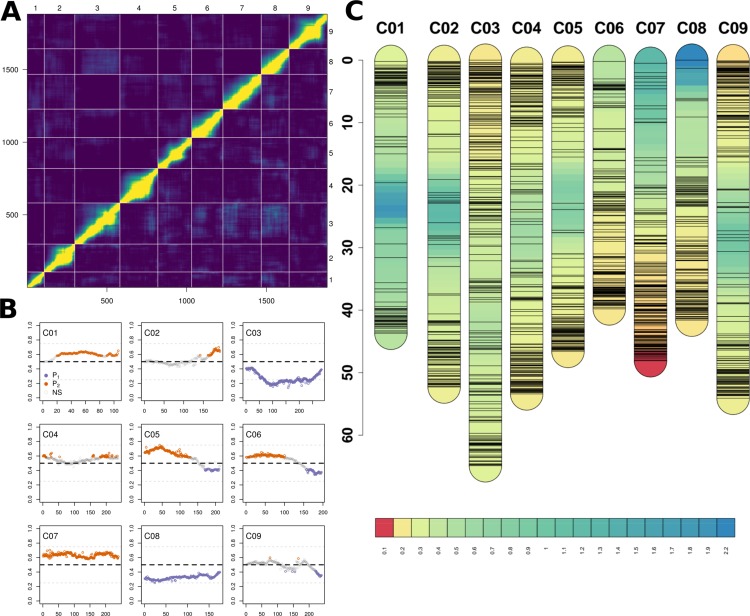
(A) Heatmap of relative recombination fractions (top left) and logarithm of odds scores (bottom right) comparing all pairs of the 1,881 markers (bottom and left axes) and by chromosome (top and right axes) used to construct BolTBDH genetic map. (B) Segregation distortion (Y-axis; f = P1 allele) observed using all markers (X-axis) disaggregatted by chromosomes (C01–C09). Markers exhibiting significant segregation distortion (χ2 [p.adj] < 0.05) plotted in orange (P1) or purple (P2). Non-significant segregation distortion markers are plotted in grey. (C) Genetic map, marker location (cm), and marker density (cm/marker) by chromosome using all 1,881 BolTBDH markers.